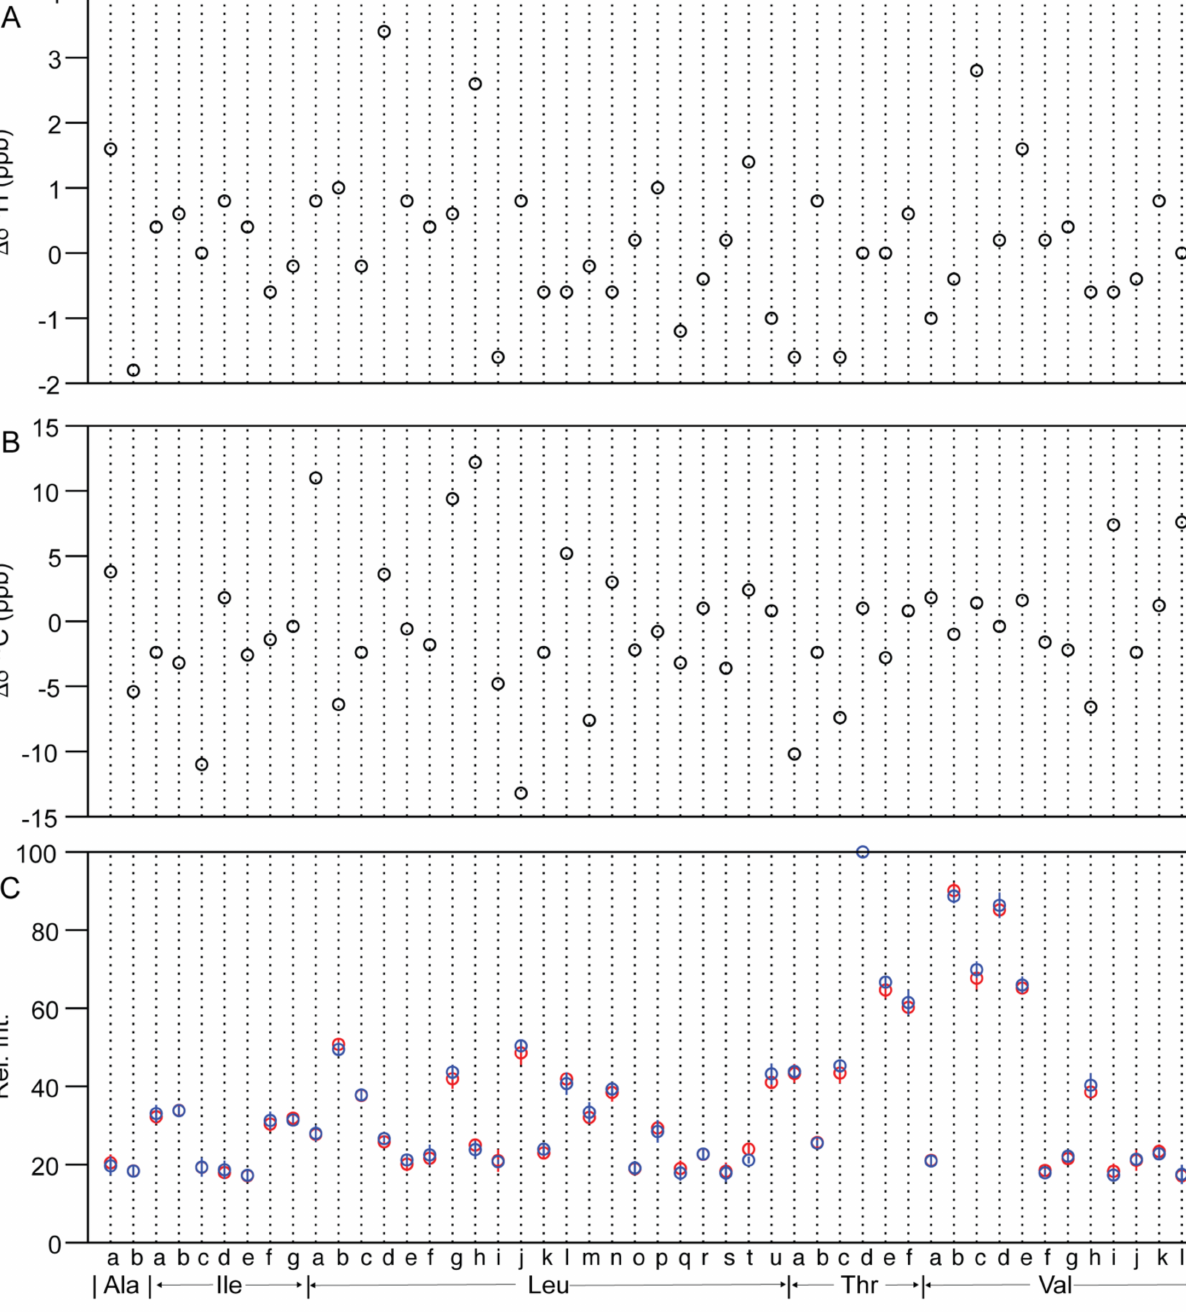
Figure 4. The chemical shift and relative peak height difference between insulin glargine drug products of Lantus ® and Basaglar ® . The 1 H ( A ) and 13 C ( B ) chemical shift difference and the relative peak heights ( C ) were plotted along the labeled peaks of Figure